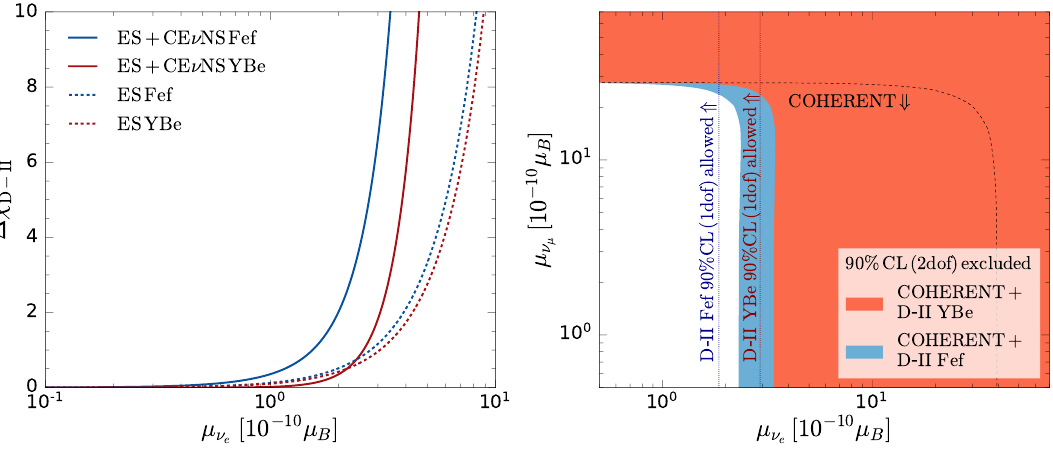
Figure 4 . Left panel: profiled ∆ χ 2 including events induced by a magnetic moment for ¯ ν e . We D − II show results including only µ ν -induced scattering off electrons (dashed curves) and for scattering off e electrons and nucleons (solid curves). In both cases the SM CE ν NS contribution is included. Right panel: 90% CL excluded (one-sided) regions from the combination of Dresden-II and COHERENT data (in color). We also indicate (with arrows) the 90% CL (one-sided) allowed regions from Dresden-II data with the Fef (blue dotted line) and YBe (red dotted line) quenching factor, and from the combined analysis of COHERENT CsI and Ar data (black dashed line). Notice that the vertical lines for the Dresden-II reactor experiment are defined one-sided for 1 dof (∆ χ 2 = 1 . 64 ), while the rest of the regions are defined for 2 dof ( ∆ χ 2 = 3 . 22